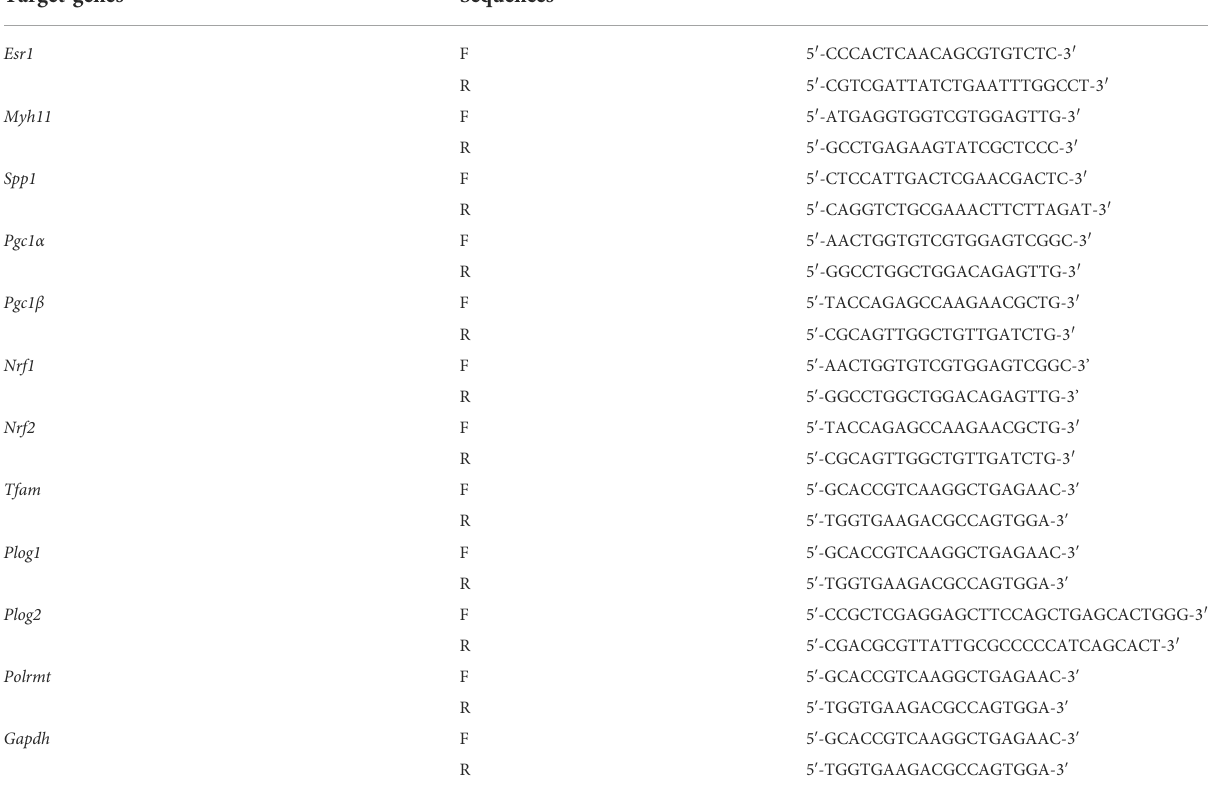
TABLE 1 Primers used for real-time quantitative polymerase chain